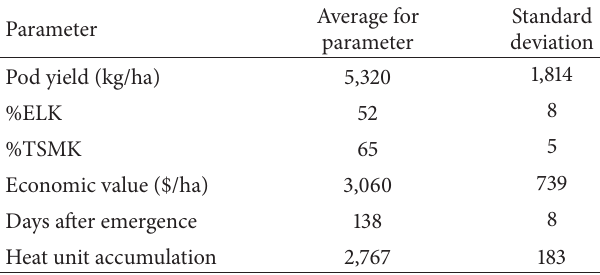
Table 5: Pearson correlations for canopy defoliation, pod yield, percentages of extra large kernels (%ELK) and total sound mature kernels (%TSMK), and economic value ($/ha) in the experiment comparing digging dates and fungicide regimes with the cultivar Gregory for experiments conducted from 2005 to